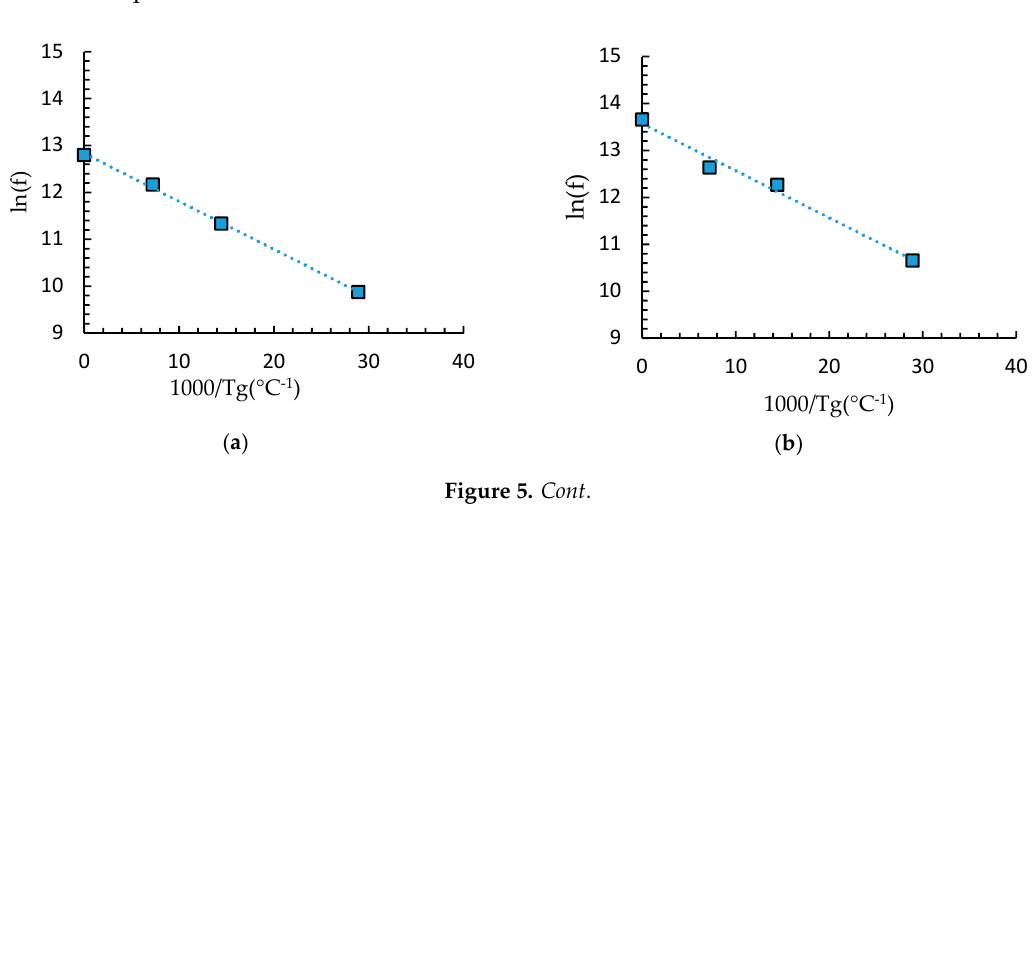
Figure 4. The viscoelastic properties of the various composites’ configurations under frequency sweep at 30 °C. ( a ) Tan delta, ( b ) Loss modulus, and ( c ) Storage modulus.